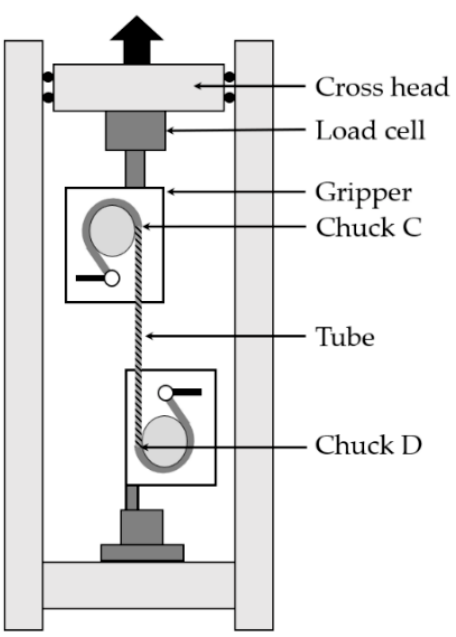
Figure 2. Schematic illustration of the method of tensile test used in this study.